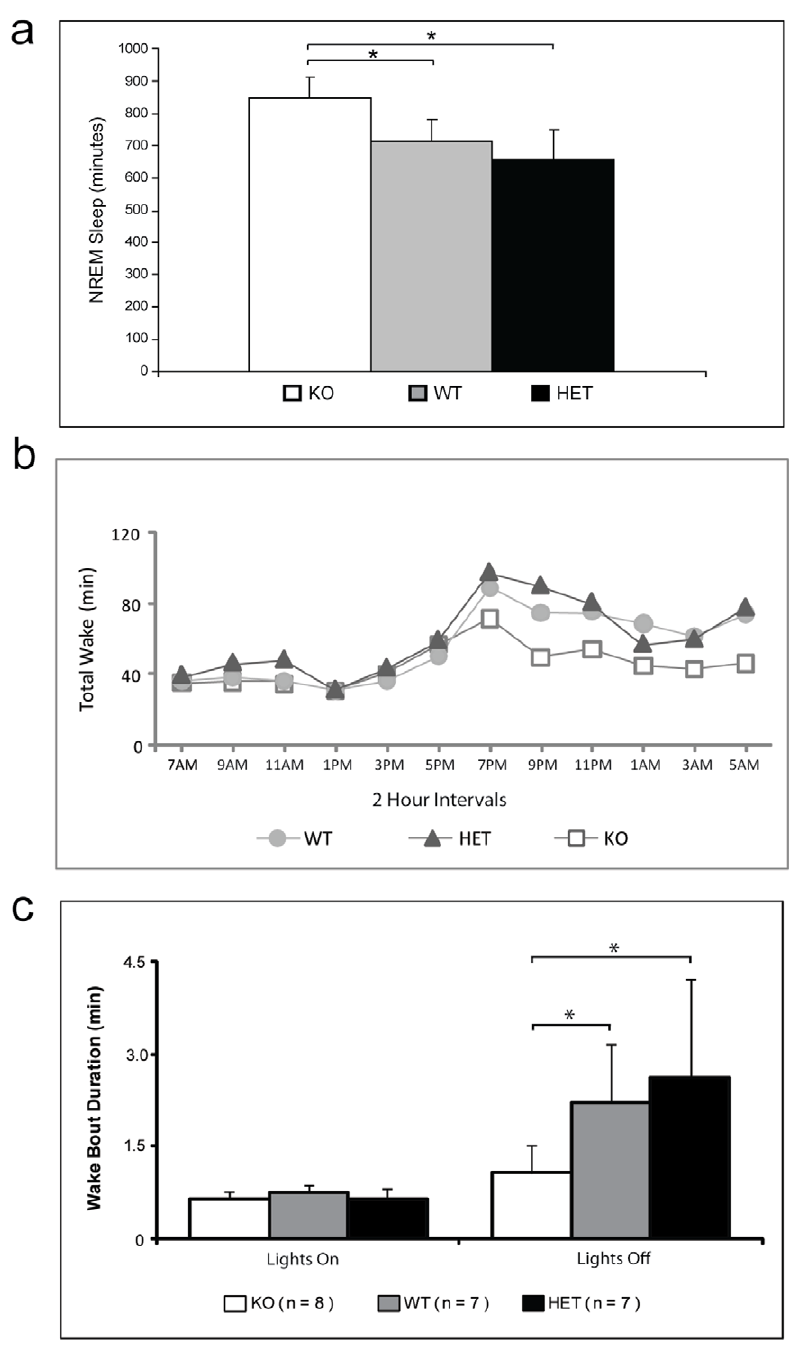
Figure 3. Loss of Homer1a reduces wakefulness. A) Total minutes of NREM sleep (left panel) and wake (right panel) over 24 hours in Homer1a knockout, Homer1a heterozygous and wildtype littermate mice. Homer1a KO mice have significantly more NREM sleep compared to the WT [847.3 6 65.4 minutes vs. 711.7 6 71.5 minutes (p=0.006)] or Homer1a HETs (655.2 6 93.5.4 minutes [p=0.0004)]. B) Total waking in all 3 genotypes across the 24 hour baseline day; averaged data are shown in 12 6 2 hour time periods. Homer1a KO exhibits less waking than either wildtype or heterozygotes but only during the nighttime active period. C) The average length of wake bouts is significantly reduced during the lights out but not the lights on period in the Homer1a knockout (KO) compared to the Homer1a heterozygotes (HET; p=0.04) and wildtype (WT; p=0.01) littermates. Mean wake bout duration and standard deviation are shown. doi:10.1371/journal.pone.0035174.g003 differences between the knockout and wildtype mice [36]. Our decarboxylase knockout [35]. The basis for this time-of-day effect data also reveal a strong time of day effect of the Homer1a is currently unknown. knockout in mice. This time-of-day effect has also been described Our data imply that the traditional wake-active neuronal for other mutants, e.g., CREB hypomorph [23], and histidine systems such as noradrenaline cells in the locus coeruleus [2],